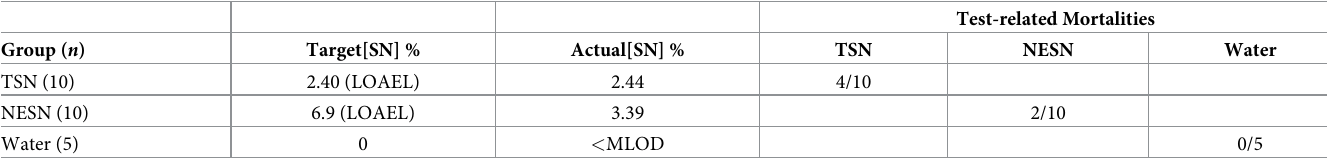
Test-related Mortalities